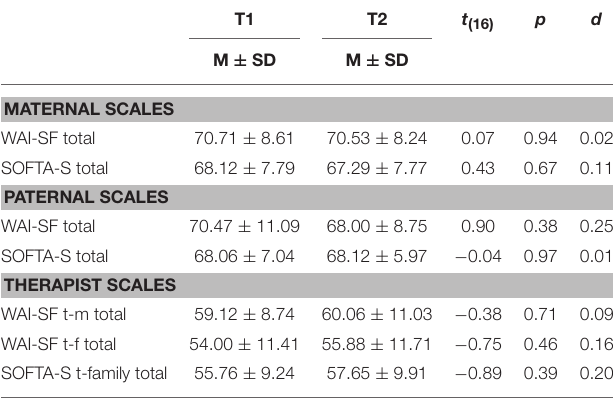
TABLE 1 | Means, SDs ofWAI-SF and SOFTA-S at T1 and T2, and tests for differences. T1 T2